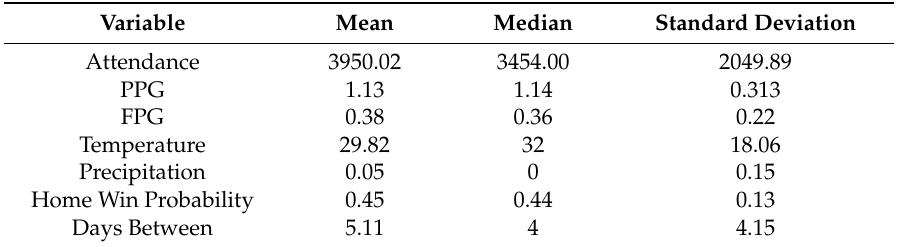
Table 1. Summary